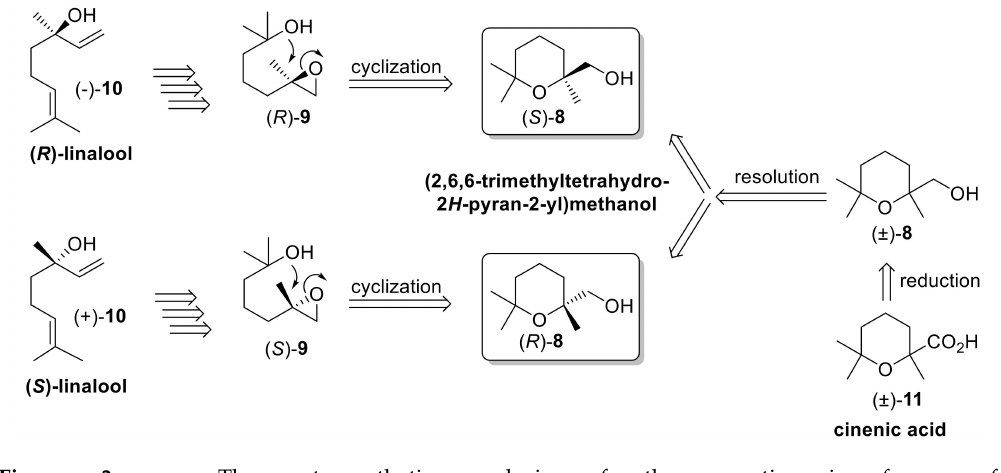
Figure 3. The retrosynthetic analysis of the enantiomeric forms of (2,6,6-trimethyltetrahydro-2 H -pyran-2-yl)methanol 8 . Two different approaches are proposed: the first is based on stereoselective synthesis ( left ) and the second is based on the resolution of racemic 8 ( right